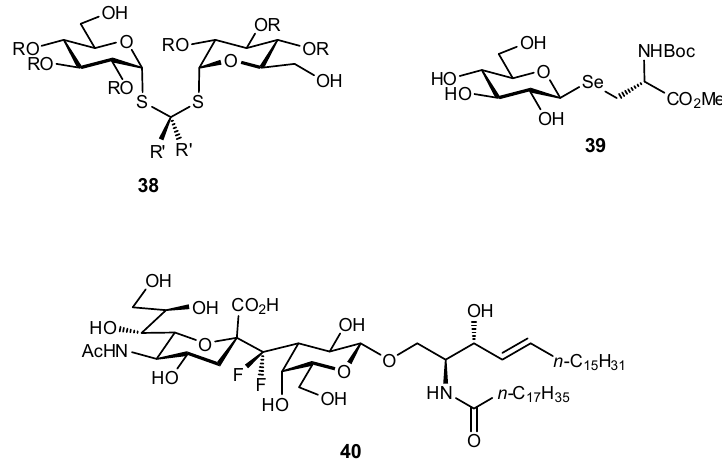
Figure 13. Examples of different O -glycoside mimetics which have been obtained synthetically, with the general aim of reducing hydrolytic degradation rates in vivo .